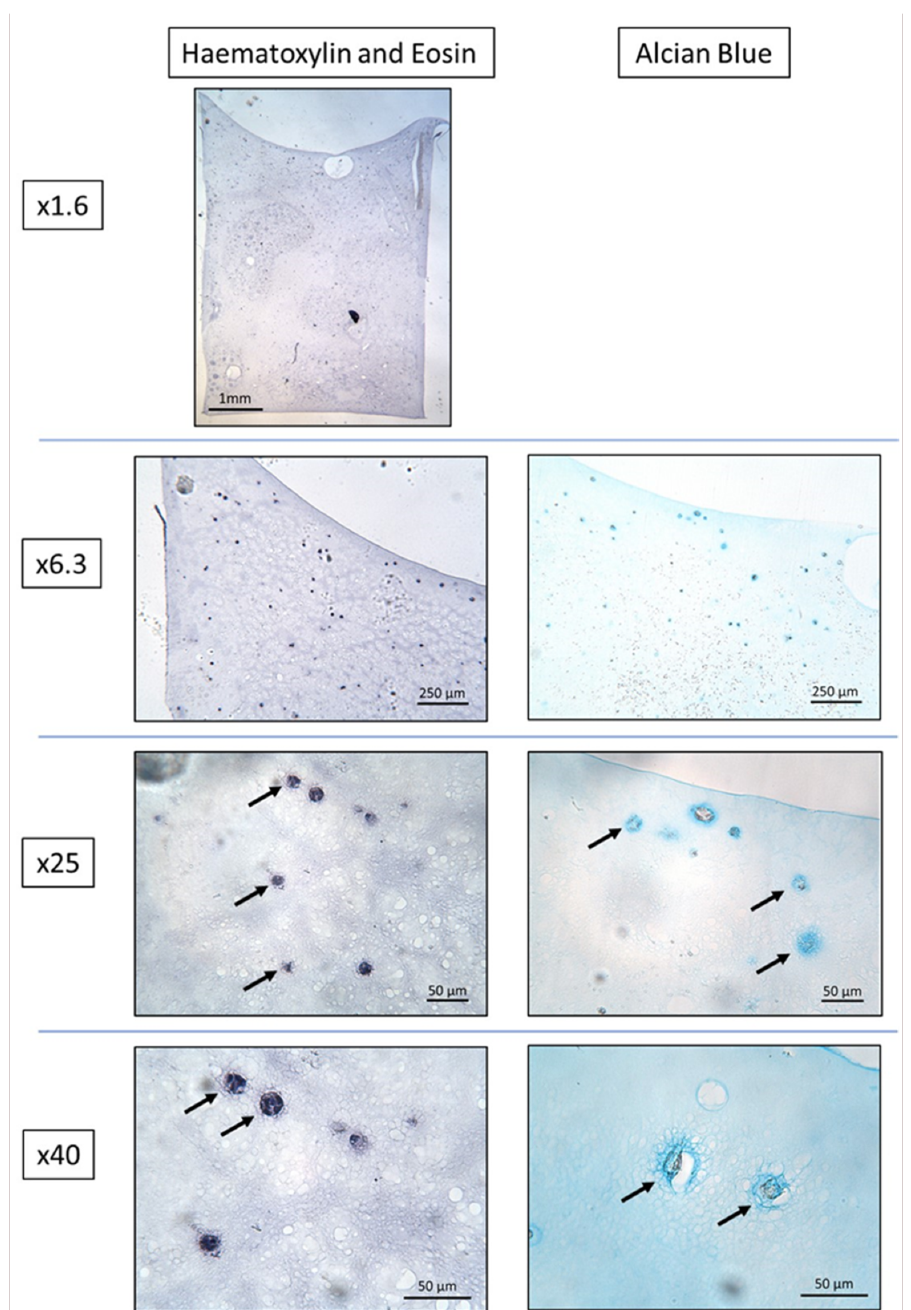
Figure 7. Representative images of H&E and Alcian Blue–stained sections from the day 21 chondrocyte-loaded agarose scaffolds co-cultured with early OA BM-MSCs. Solid arrows: chondrocytes. Note the Alcian Blue staining surrounding the chondrocytes, indicating GAG